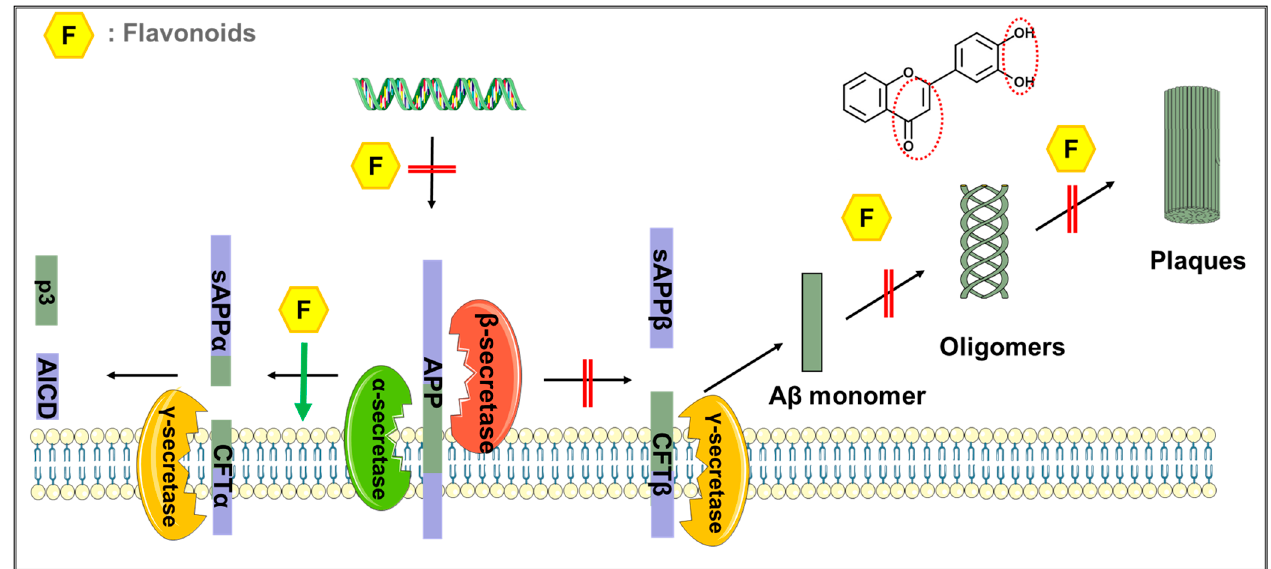
Figure 3. Flavonoids exert anti-AD effects by interacting with A β . Flavonoids exert anti-amyloido- genic effects through: (1) decreasing the levels of APP; (2) reducing A β production by regulating APP processing; and (3) preventing the aggregation of A β . The structural characteristics for inhibi- tory activity against the aggregation of A β include a catechol group and in the B ring and a 2,3- double bond in the C ring. The double red line represents the inhibitory effect, and the green arrow represents the promoting effect.